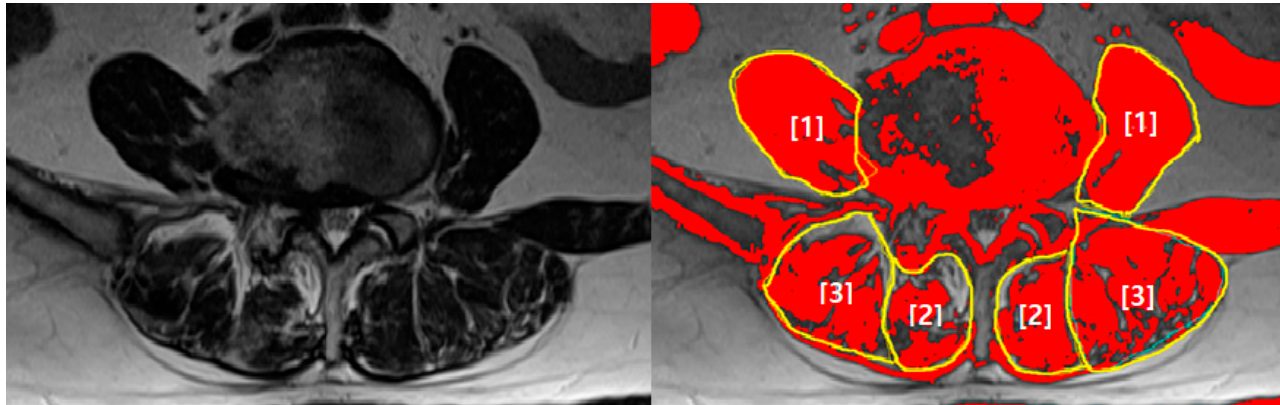
Figure 1. Measurement of CSAs and FCSAs on a representative T2-weighted magnetic resonance (MR) image. ( Left ): original T2-weighted MR image. ( Right ): T2-weighted MR image showing CSAs as the area surrounded by the yellow lines and FCSAs as the red colored areas. (1): Psoas, (2): Multifidus, (3): Erector spinae; CSA, cross-sectional area; FCSA, functional cross-sectional area.